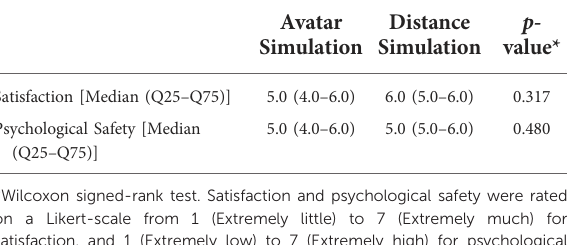
TABLE 3 Satisfaction and psychological safety with avatar simulation and distance